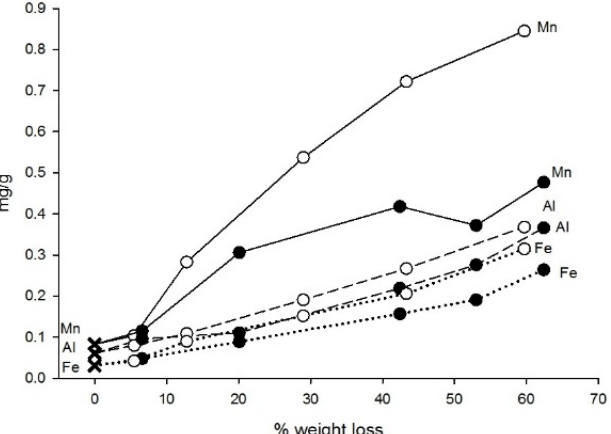
Figure 7. Changes in the concentration of manganese (solid lines), aluminium (stippled lines) and iron (dotted lines) during decomposition of cones. Filled circles: moss habitat. Open circles: needle mat habitat.